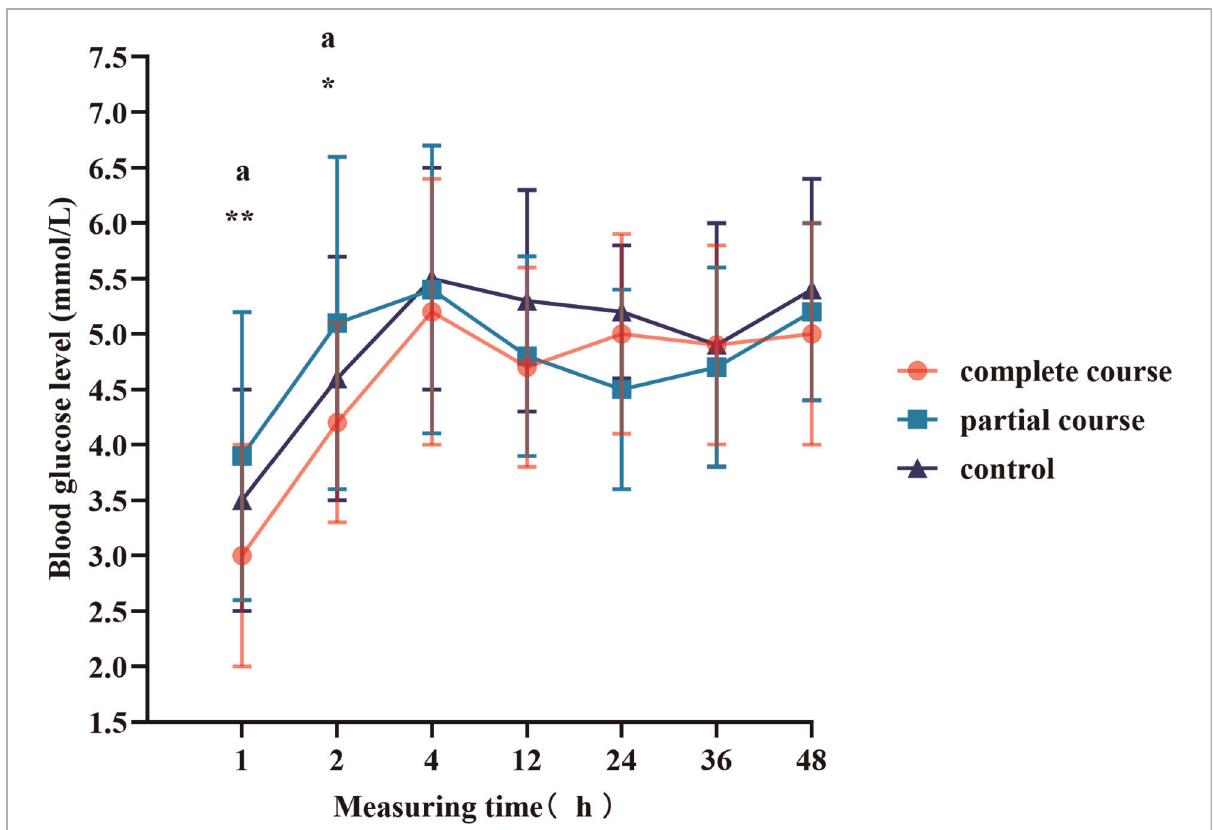
FIGURE 4 Blood glucose levels of female infants at different time points. Comparison of blood glucose levels of female infants among all groups, * p <0.05, ** p <0.01, *** p <0.001; a p <0.0167 for the comparison of the partial course group with the control